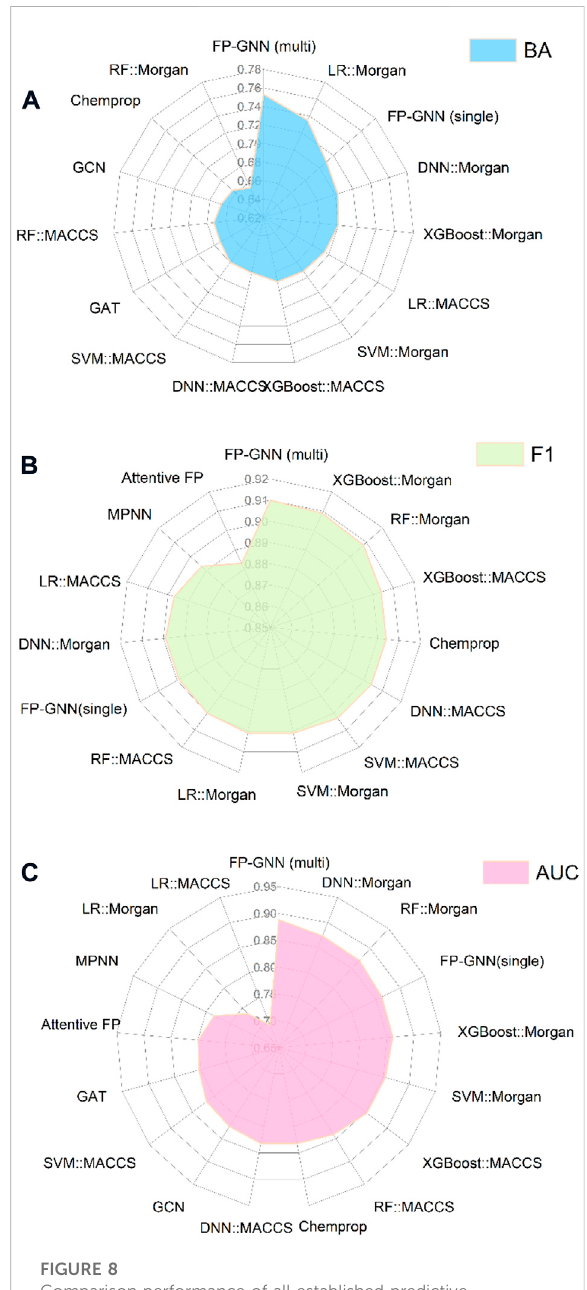
FIGURE 8 Comparison performance of all established predictive models. (A) , (B) , and (C) represent the average BA, F1, and AUC values of the test